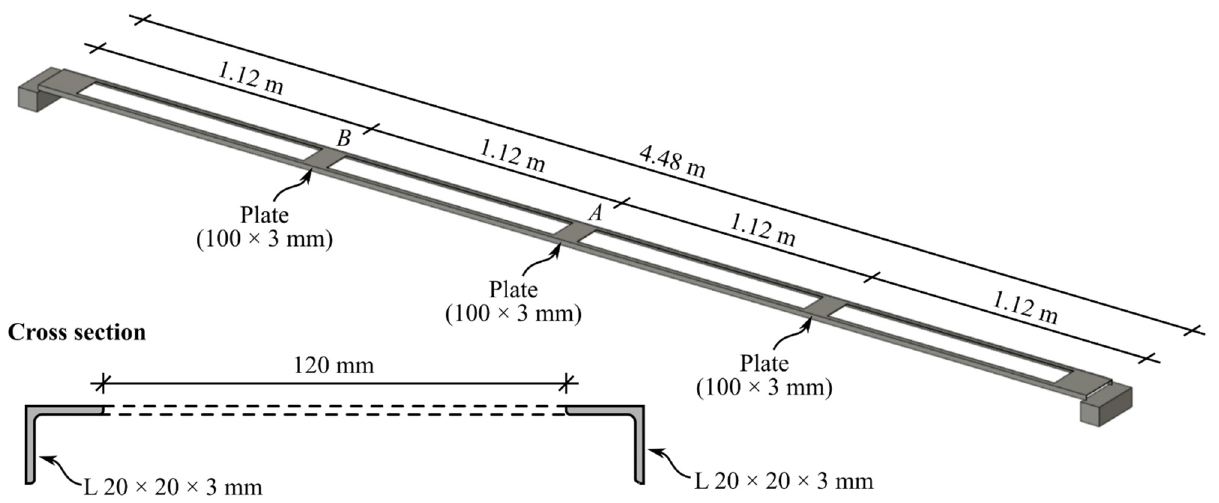
Figure 5. Schematic longitudinal representation of the steel beam along with typical cross section.